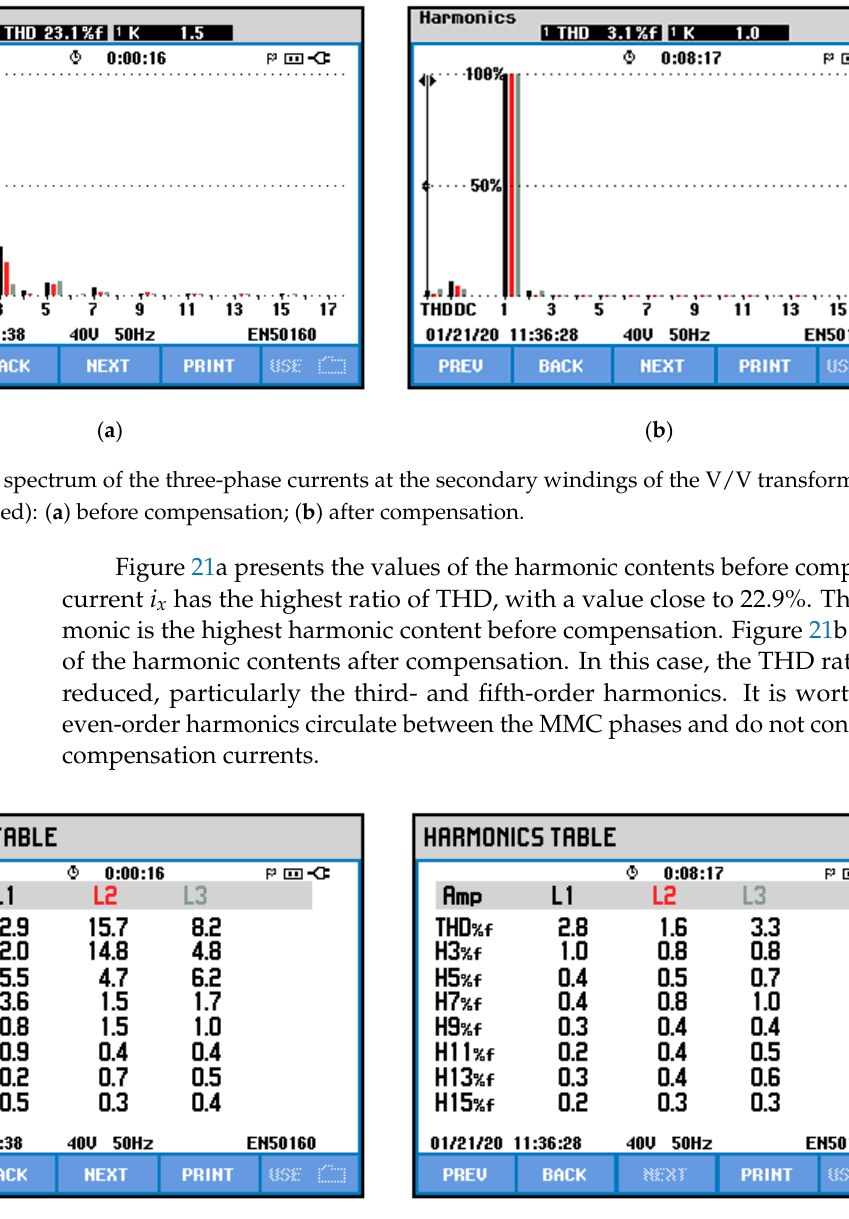
( b ) Figure 19. Experimental results when two load sections are loaded: ( a ) before compensation; ( b ) after compensation. Phase x current ( i x : 5 A/div); phase y current ( i y : 5 A/div); phase A voltage ( u A : 100 V/div). Figure 18b presents the three-phase currents at the secondary windings of the V/V transformer after compensation. The currents are balanced with lower harmonic content and without NSCs. In this case, the RPC compensates reactive power and balances the active power between the load sections. Consequently, a unitary power factor is obtained at the three-phase power grid. In addition, there are almost 0° out-of-phase between u A and i x , and almost 120°out-of-phase between u A and i y after compensation, as presented in Figure 19b. This means the reactive power is totally exchanged between the load sections and the power compensator. There is no reactive power exchanged with the three-phase